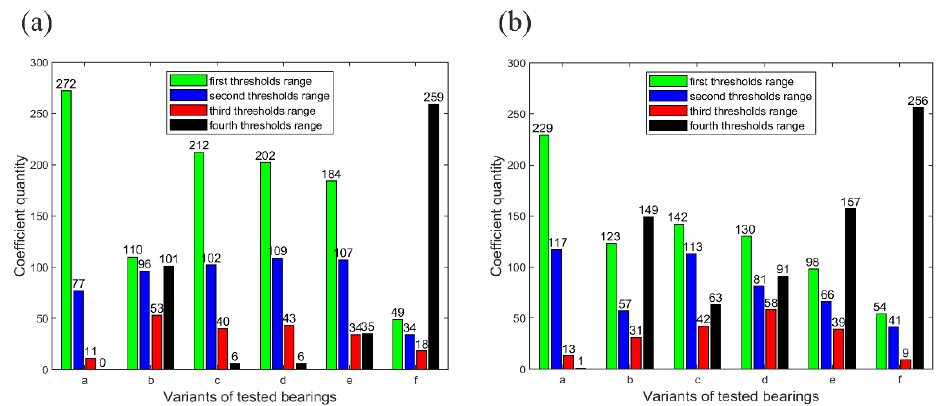
Figure 10. Collective characteristics of the damage maps of the SKF 1207K bearing from the side of: ( a ) the drive ( b ) the brake for the shaft speed of 900 rpm.